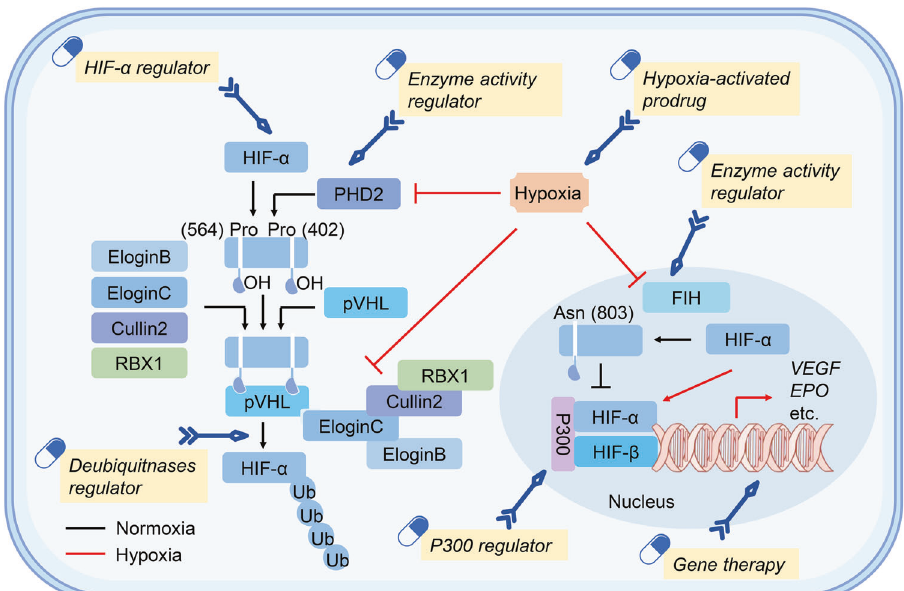
Fig. 7 The principle of therapeutics targeting hypoxia signaling. The stratigies of therapeutics targeting hypoxia signaling are classi fi ed in (1) HIF-1 α regulator; (2) Enzyme activity regulator; (3) deubiquinases regulator; (4) hypoxia-activated prodrug; and (5) P300